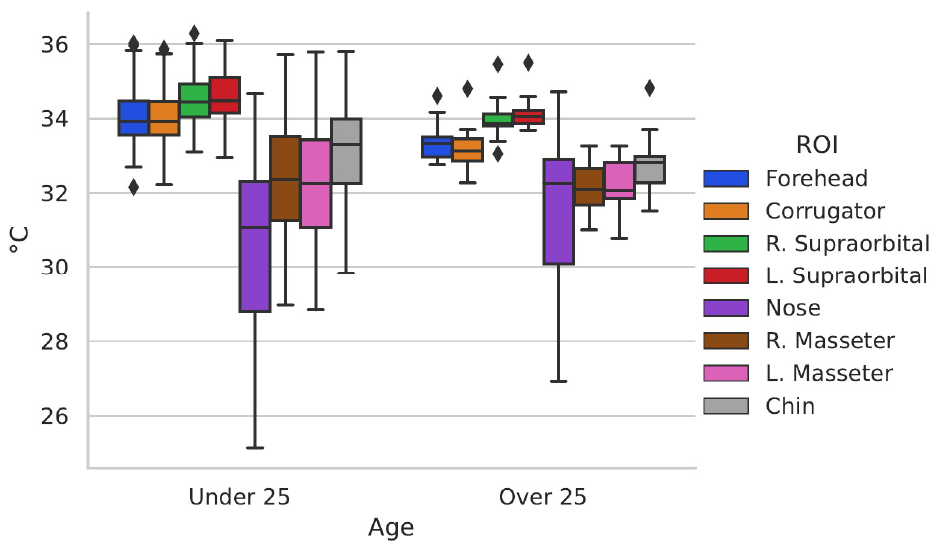
Figure 6. Box-and-whisker chart comparison by age. Figure 8. Box-and-whisker chart Control and Clinic